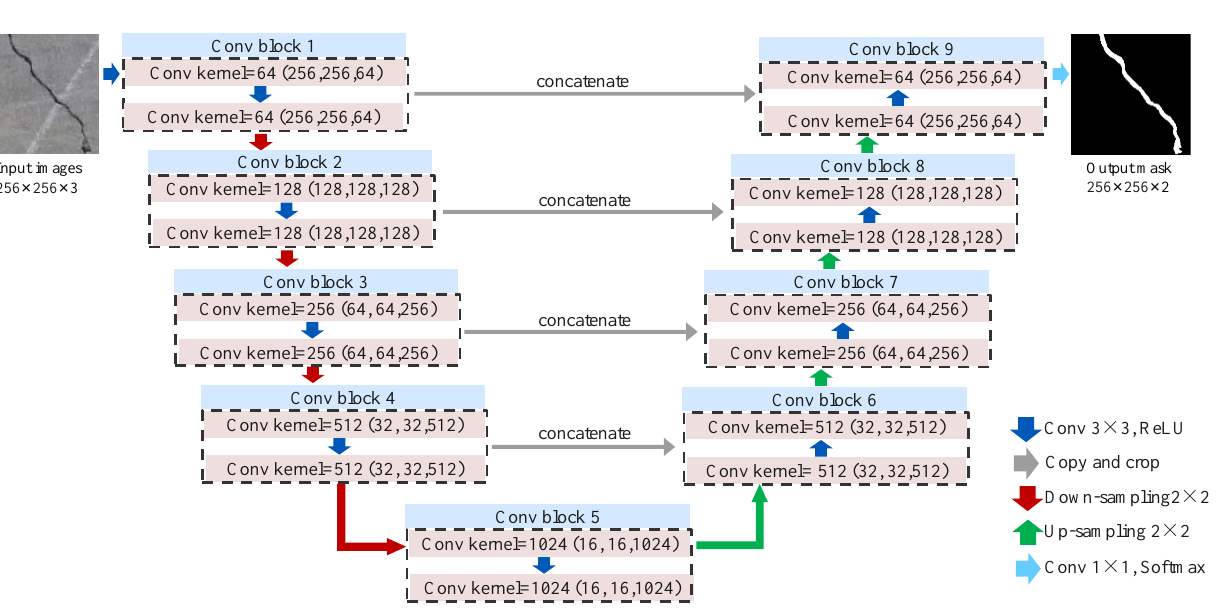
Figure 8. Architecture of U-net network for crack segmentation.